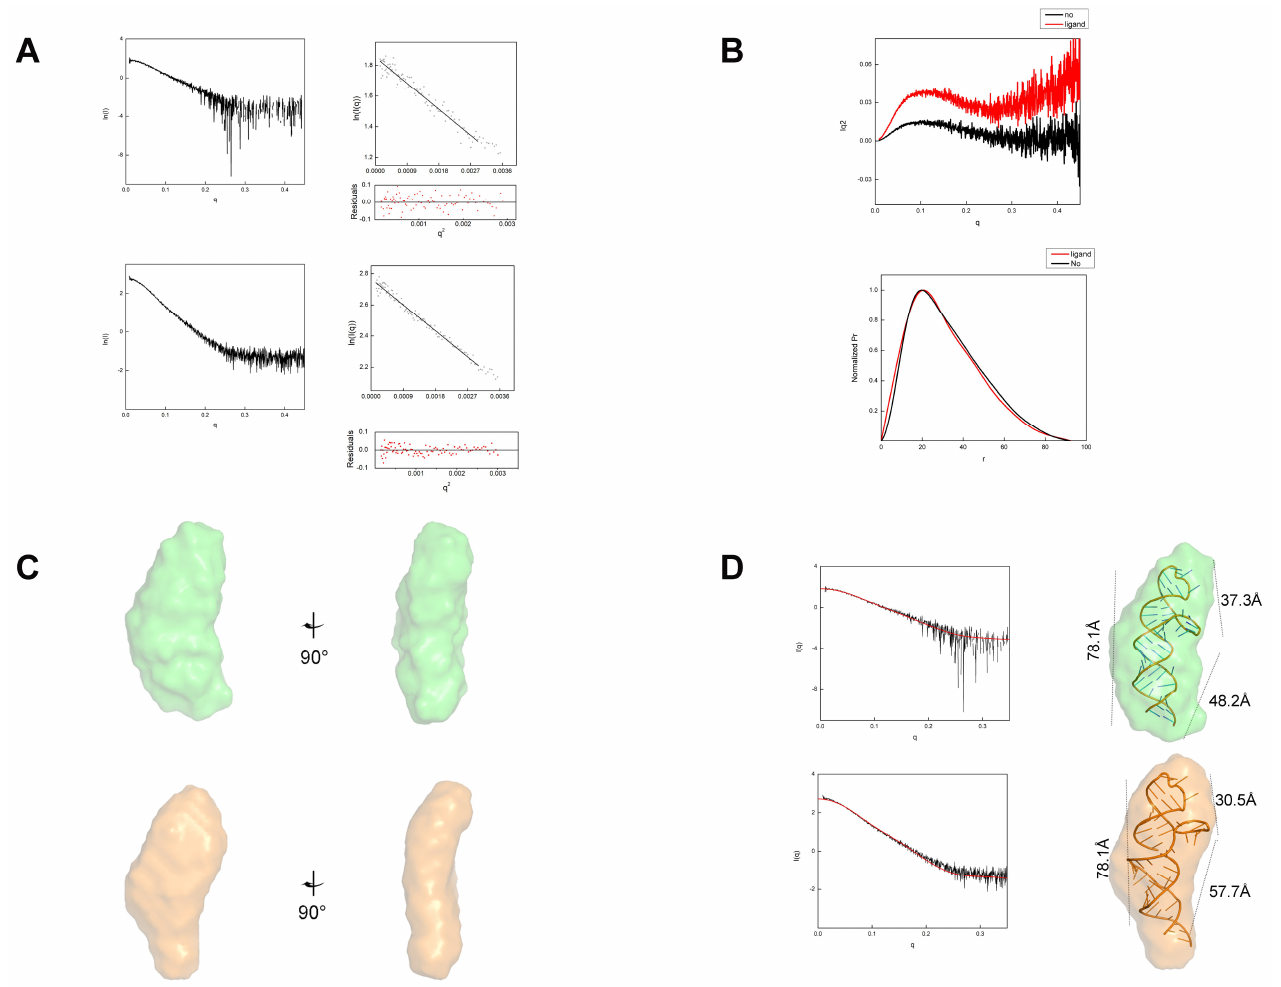
Figure 4. Tetrahydrofolic acid binds to the THF-II riboswitch and induces conformational changes. ( A ) Comparison of experimental scattering profiles ( left ) and Guinier plot ( right ) of the THF-II riboswitch, the ligand-free THF-II riboswitch (upper series) and the ligand-bound THF-II riboswitch (lower series). ( B ) Kratky plot ( upper ) and normalized P(r) analysis ( lower ) of the THF-II riboswitch, the ligand-free THF-II riboswitch (black) and the ligand-bound THF-II riboswitch (red). ( C ) Low- resolution bead models calculated by DAMMIF from the SAXS data. The ligand-free THF-II ri- boswitch (upper series) is shown in orange, and the ligand-bound THF-II riboswitch is shown in yellow. ( D ) Predicted atomic models of the THF-II riboswitch docked inside the SAXS bead models. The theoretical scattering curve of the THF-II riboswitch predicted atomic structure (red) was com- pared to the experimental scattering curves (black) by CRYSOL. The coloring of the bead models of the ligand-free THF-II riboswitch (upper series) and ligand-bound THF-II riboswitch (lower series) is consistent with that in panel ( C ). Distances between Loop1 and Loop2, P1 and Loop2 and P1 and Loop1 measure d37.3 Å, 78.1 Å and 48.2 Å, respectively, in the ligand-free state (Figure 4D, upper series), while those in the ligand-bound state measured 30.5 Å, 78.1 Å and 57.7 Å (Figure 4D, lower